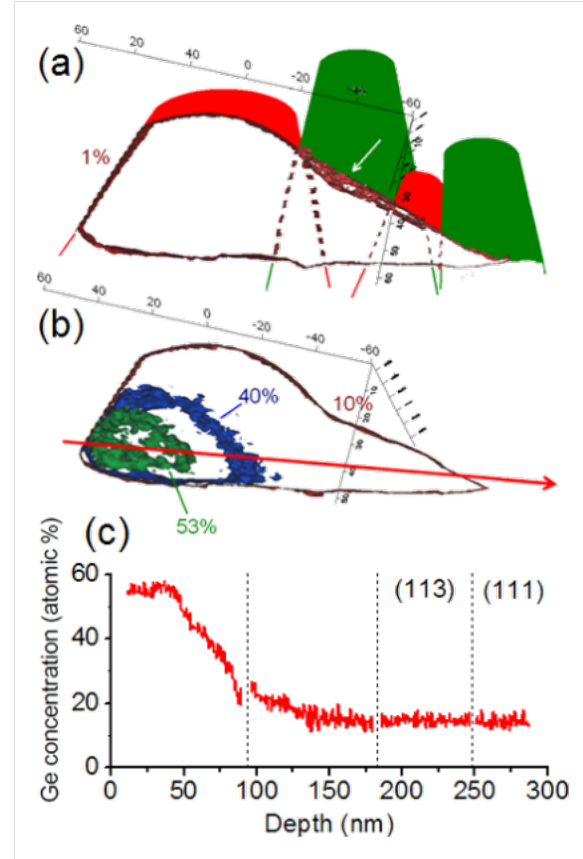
Figure 11: APT measurements obtained for four APT volumes (green and red surfaces) which form almost half of a Ge island: (a) Ge isocon- centration surface of 1 atom %, (b) Ge isoconcentration surfaces of 53, 40 and 10 atom %, and (c) Ge 1D concentration profile measured in the direction indicated by the red arrow in